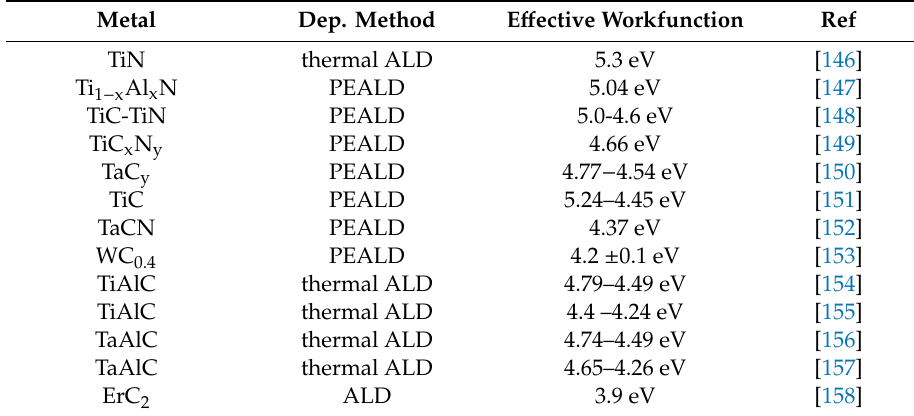
Table 1. The e ff ective workfunction of di ff erent metals grown by atomic layer deposition (ALD) for